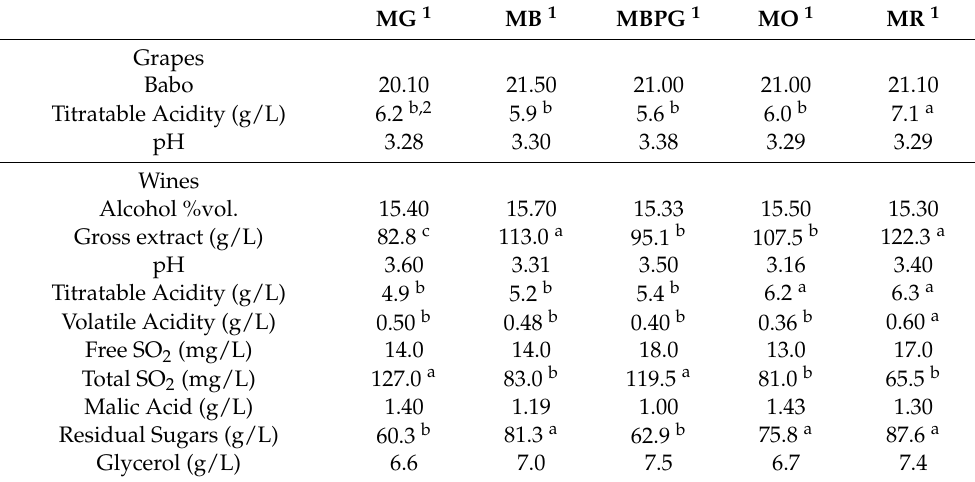
Table 1. Physicochemical parameters (average values) of grapes and wines from different Moscato